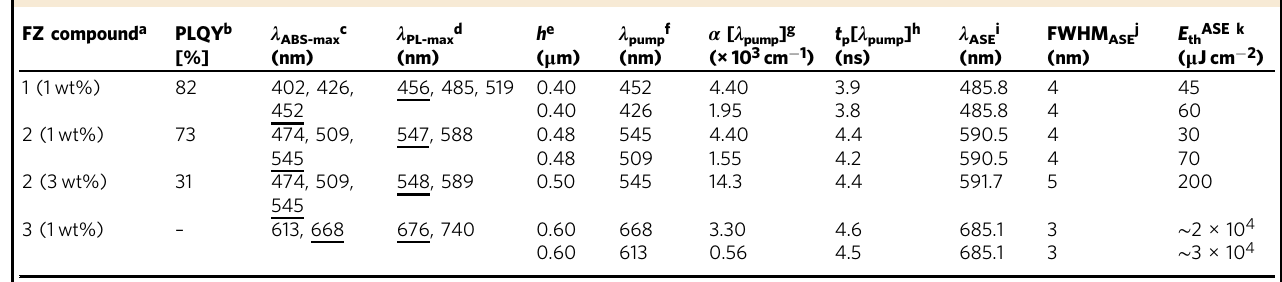
a Number of nanographene compound, among 1, 2 and 3; doping rate (error ~0.1wt%) in PS indicated in brackets b Photoluminescence quantum yield (error ∼ 10%) c Peak absorption wavelengths (maximum absorption peak is underlined) d Peak photoluminescence wavelengths (maximum photoluminescence peak is underlined) e Film thickness (error ∼ 2%) f Pump wavelength g Absorption coef fi cient at λ pump (error ∼ 2%) h Pump pulse width at λ pump i Ampli fi ed spontaneous emission (ASE) wavelength (error is±0.5nm) j ASE linewidth (error is±1nm), de fi ned as the full width at half maximum, FWHM, well above the threshold k ASE threshold (error ∼ 20%), determined from plots such as those of Supplementary Fig. 2, as the incident pump energy density at which the FWHM decays to half of its maximum